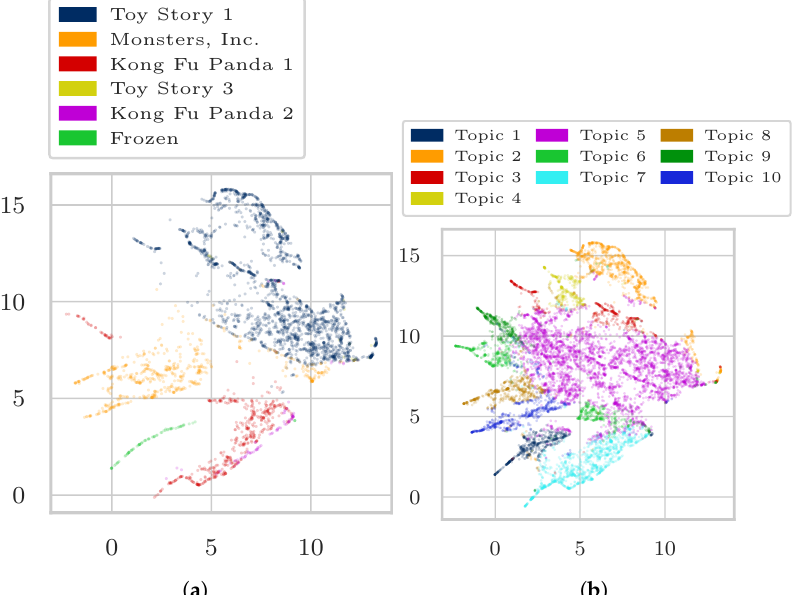
Figure A12. ( a ) 2-dimensional representation of word embeddings A colored by topic assignment. ( b ) 2-dimensional representation of word embeddings A colored by original review article.